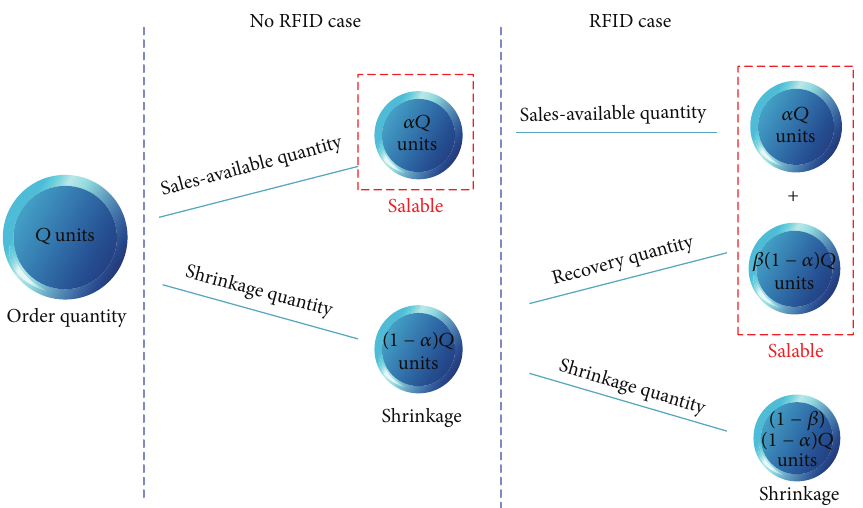
Figure 1: RFID implementation versus no RFID case in the retail